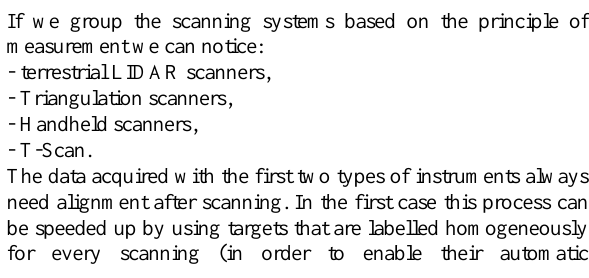
Figure 2. A statue surveyed by T-Scan and Laser Tracker